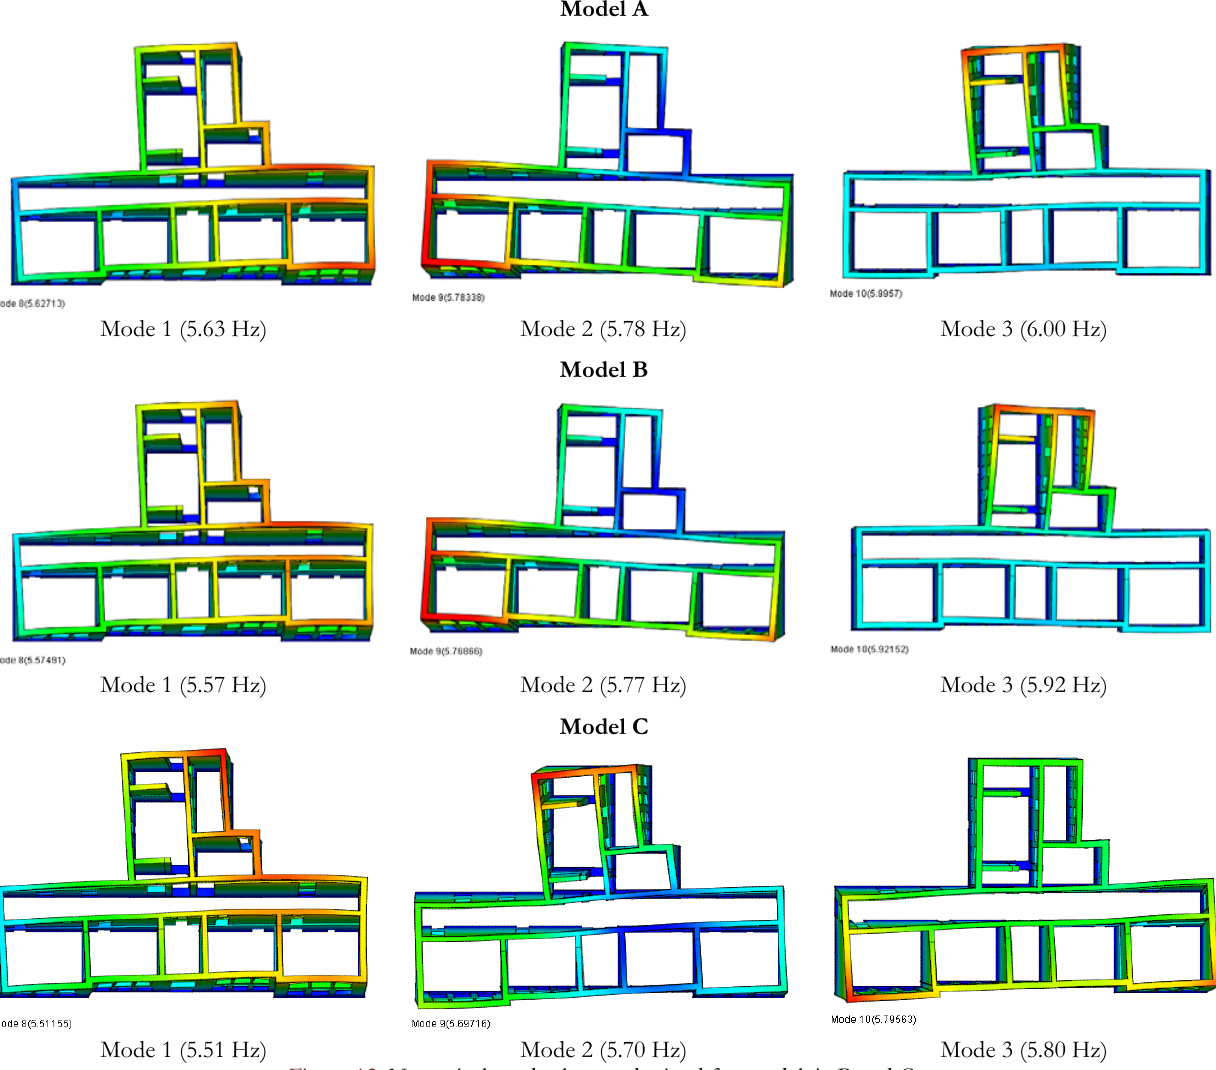
Figure 12: Numerical mode shapes obtained for model A, B and